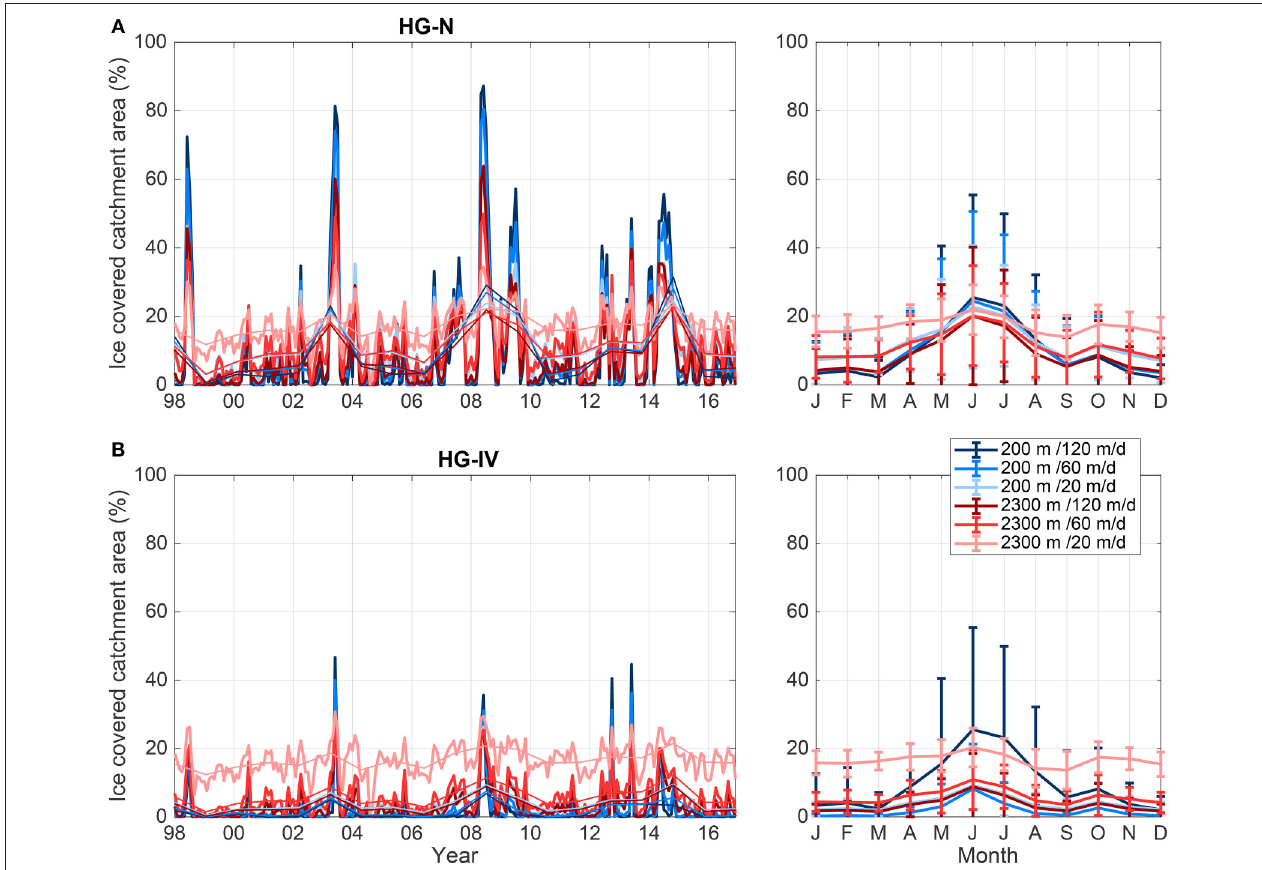
FIGURE 5 | Monthly mean (thick lines) and annual mean (thin lines) ice coverage of the catchment area (in %) of sediment traps (A) HG-N and (B) HG-IV for the time period 1998–2016 (left) and its seasonal cycle (right). Error bars in the right panel show the standard deviation of the monthly mean values.